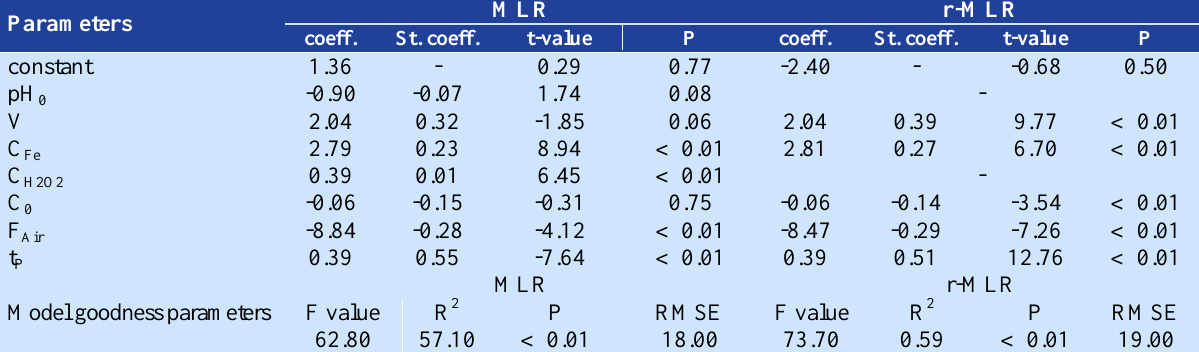
Table 3. The multiple linear regression (MLR) and reduced multiple linear regression (r-MLR) models along with statistics of parameter influences